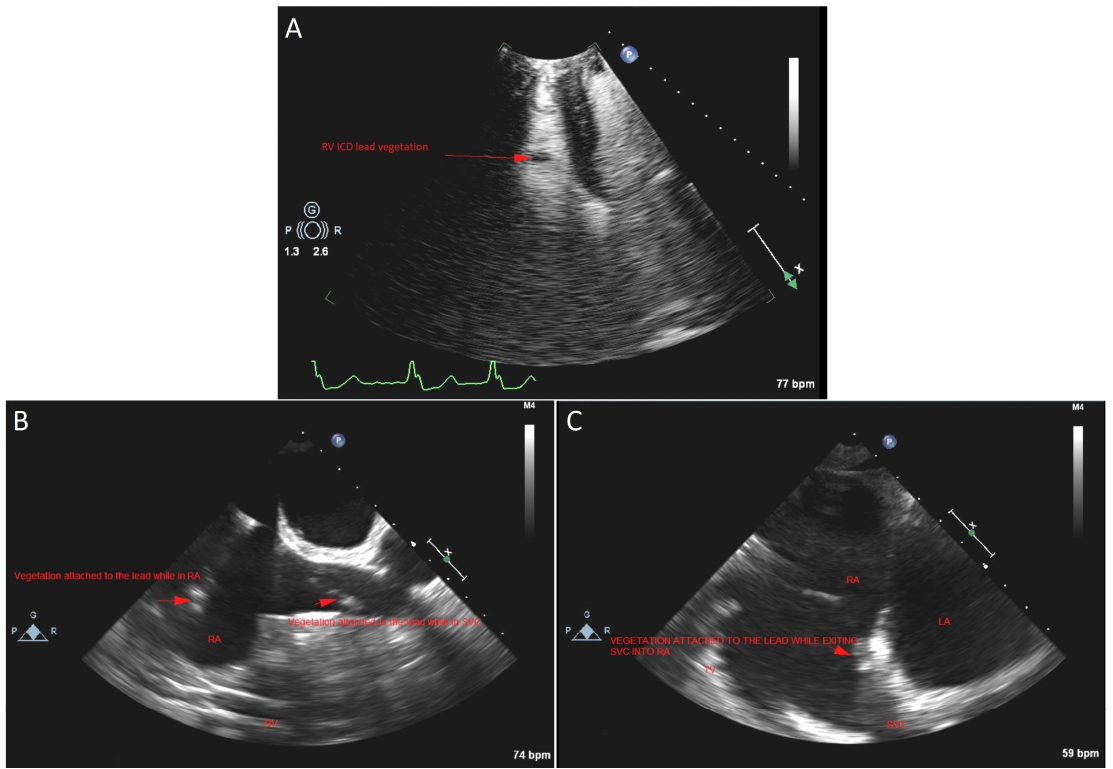
Figure 2. ( A ) Transthoracic echocardiogram (TTE) view that shows right ventricle (RV) ICD lead vegetation. ( B ) Transesophageal echocardiogram (TEE) view that shows vegetation attached to the ICD lead in the superior vena cava (SVC), but also vegetation attached to the lead while in the right atrium (RA). ( C ) TEE view that shows a small mass attached to the ICD lead while exiting the SVC into the RA, suspicious for vegetation. LA: left atrium.